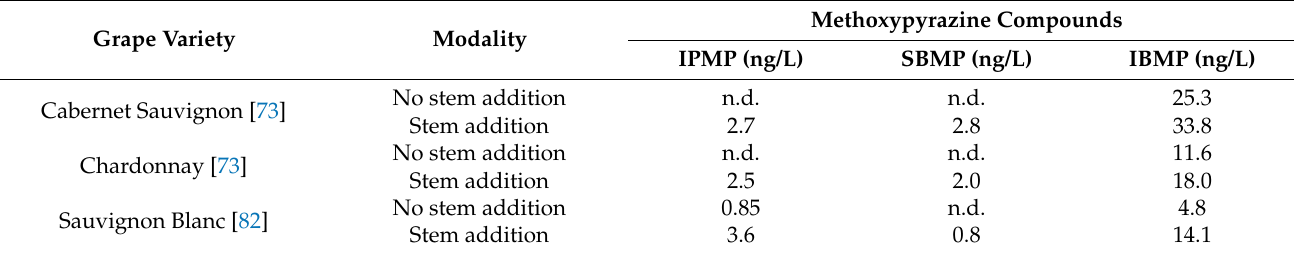
Table 22. Impact of stems on methoxypyrazine composition in wine